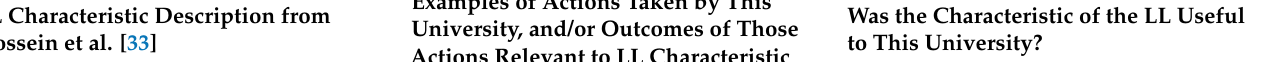
Table 5. Examples of actions taken by the university relevant to Hossein et al.’s [33] LL characteristics, with an assessment of the usefulness of each LL characteristic to this